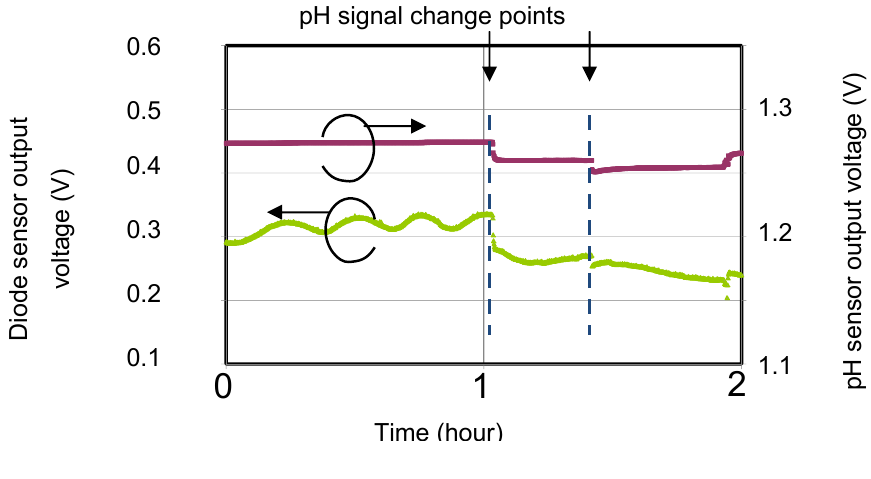
Figure 2. Diode signal affected by changes in the pH signal without a layer shielding the diode.